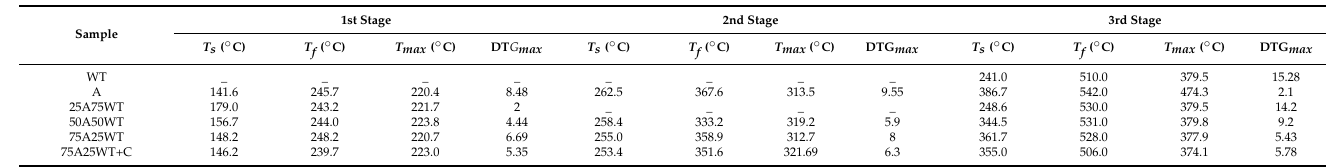
Table 2. The main parameters of AP, WTS, and their blends with and without HZSM-5 obtained from the TGA at 25 ◦ C/min.